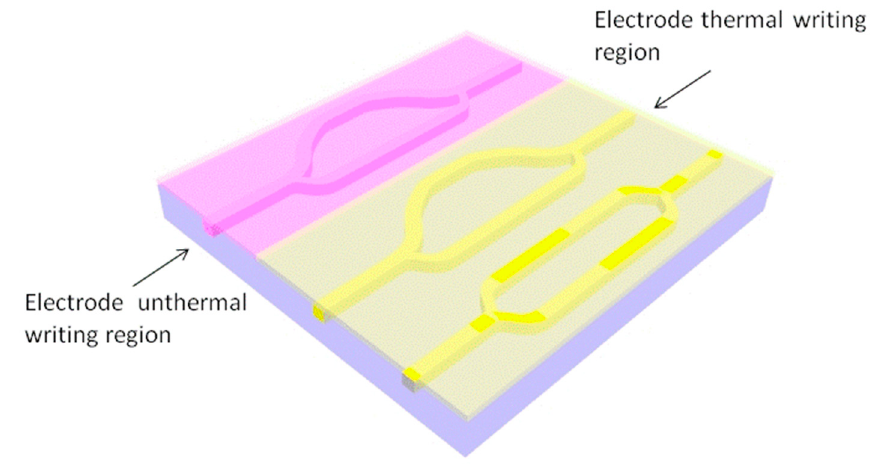
Figure 4. The schematic of the asymmetric Mach–Zehnder (M–Z) waveguide arrays.